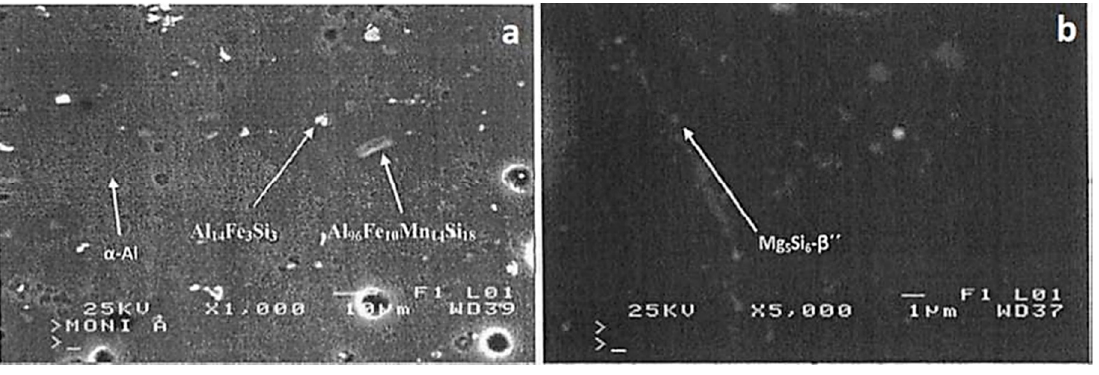
Figure 2. SEM micrographs showing ( a ) the microstructure of the T6 treated 6082 aluminum alloy and ( b ) the distribution of β″ (Mg 5 Si 6 ) precipitates along the grain boundaries of this alloy.